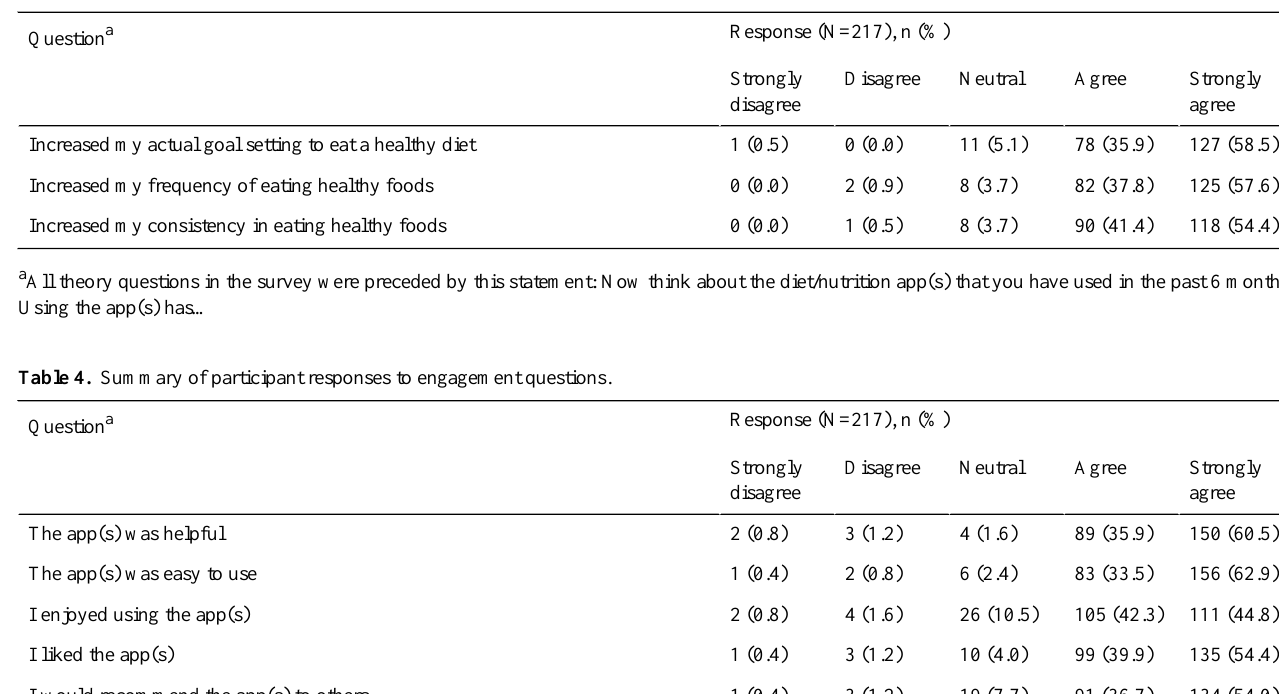
Table 3. Summary of participant responses to behavior change questions.